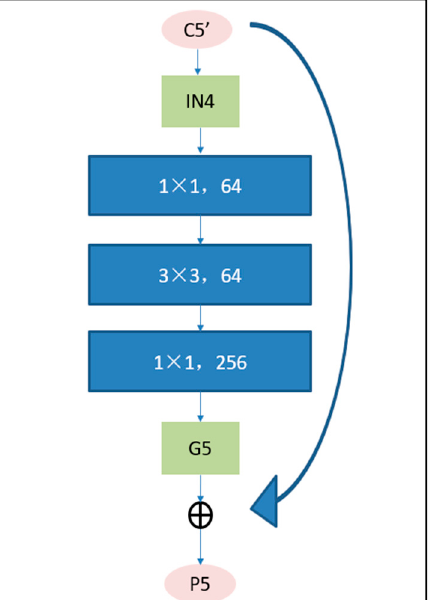
Figure 3. The progress of feature enhancement.